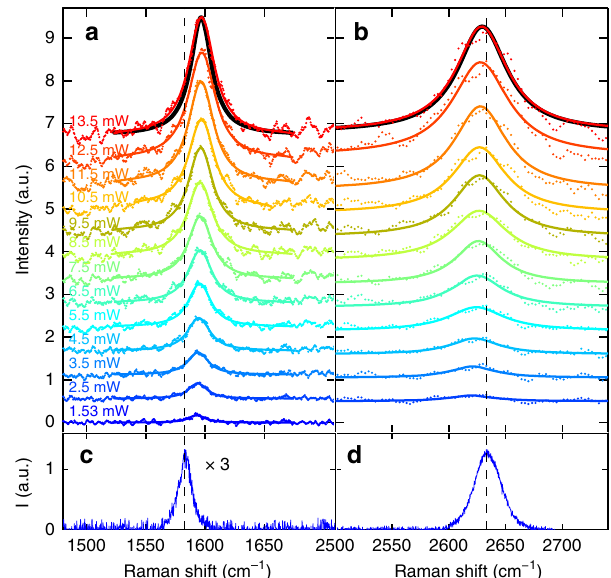
Fig. 2 Raman spectra at different laser power. a AS G and b 2D peak as function of P L . (dots) Experimental data. (Lines) fi tted Lorentzians convoluted with the spectral pro fi le of the excitation pulse. The vertical dashed lines are the equilibrium, RT, Pos(G) and Pos(2D). c RT CW S G and d 2D peaks. The CW 2D is shifted by 5.4 cm − 1 for comparison with the AS ps-Raman, see Methods. The relative calibration accuracy is ∼ 2 cm −